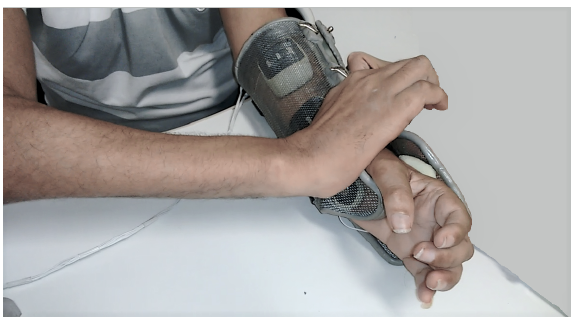
Figure 11. SCI individual donning the orthosis.